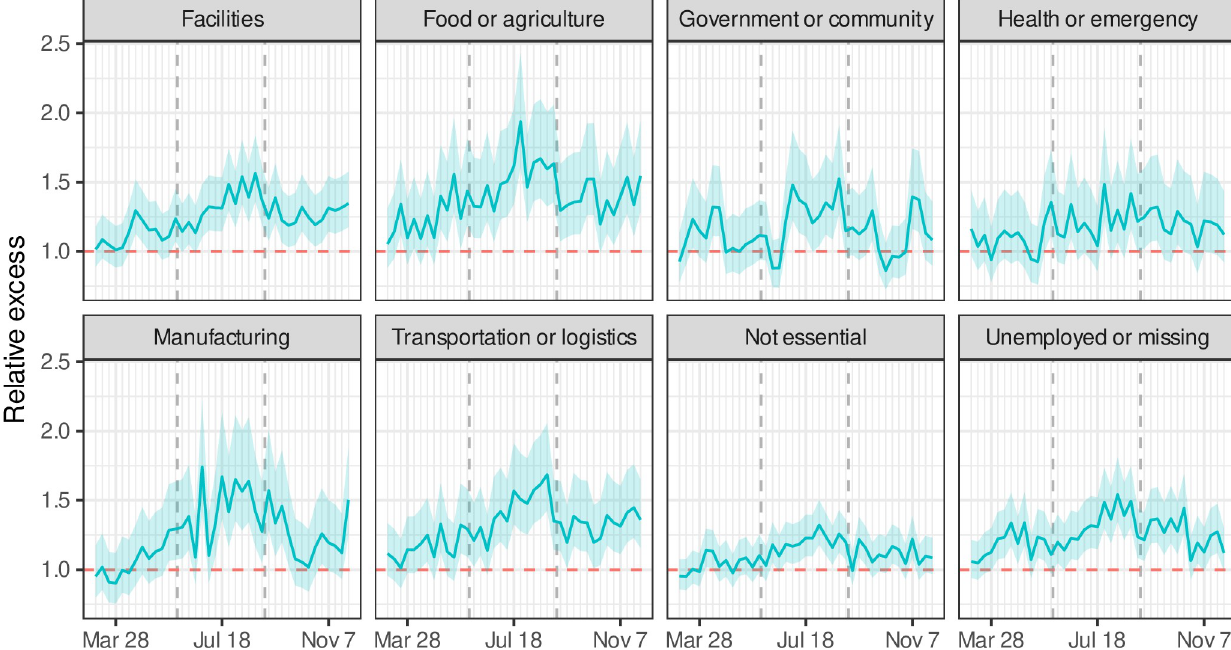
Fig 2. Relative excess mortality among Californians 18–65 years of age, by occupational sector, March through November 2020. The dashed vertical lines separate the first 3 quarters of the first year of the COVID-19 pandemic. The quarters roughly correspond to major policy decisions, after accounting for lags from policy decisions to infection to death. The first quarter corresponds to a period of sheltering in place, the second quarter corresponds to a period of reopening, and the third quarter corresponds to a period of business closures.